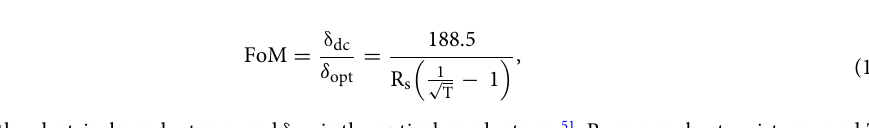
Figure 7. ( a ) Variation graph of sheet resistance during the adhesive tape test and. ( b ) AFM diagram of copper wire